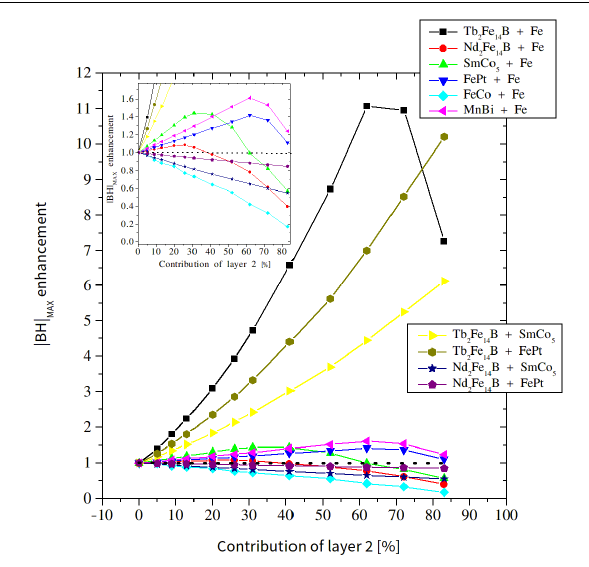
Figure 11. Relative change of the | BH | max parameter as a function of the “layer 2” content. Table 3. The | BH | max , parameters, | BH | max enhancements, coercive field H c s, and the “layer 2” contents at the optimal points.